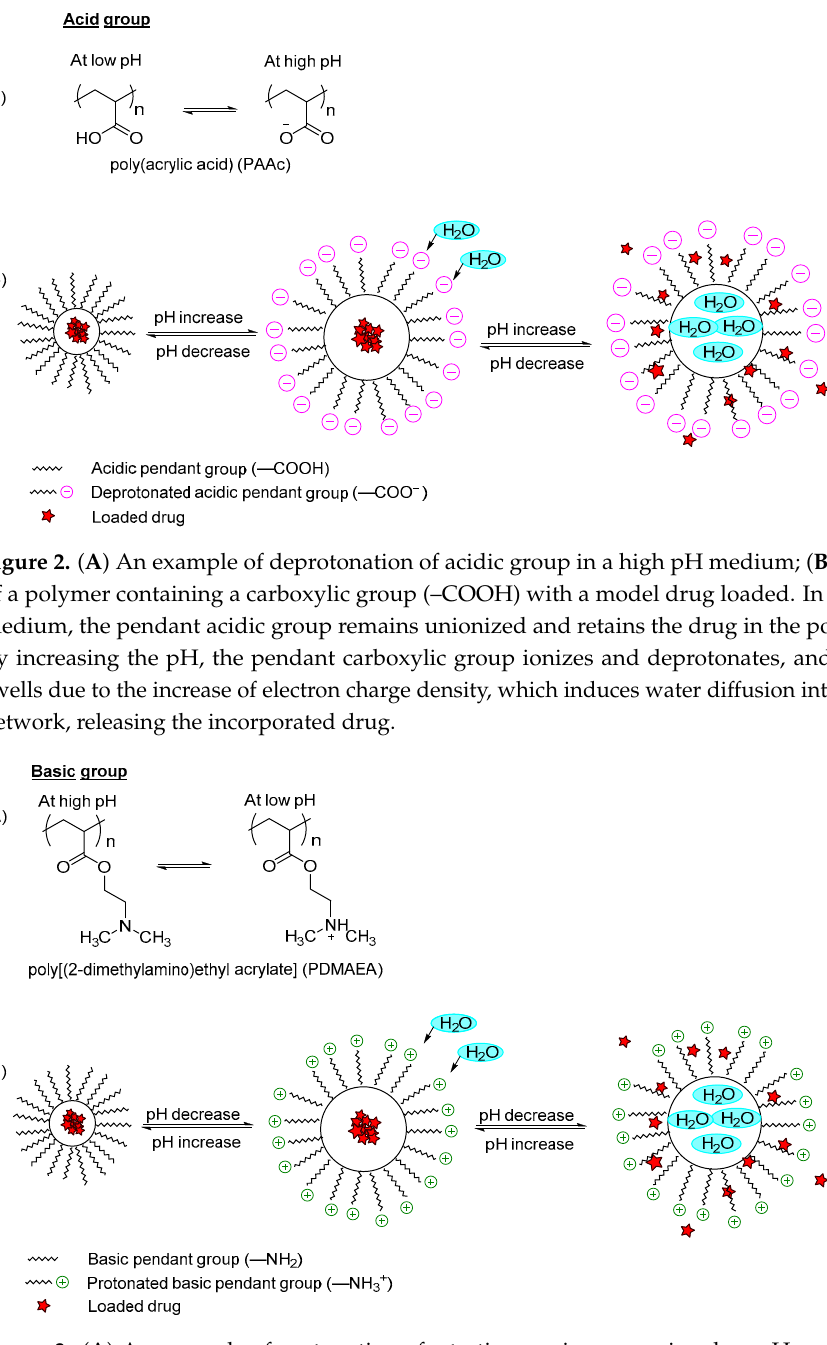
Figure 3. ( A ) An example of protonation of a tertiary amine group in a low pH medium; ( B ) An example of a polymer containing an amino group (–NH 2 ) with a model drug loaded. In a basic pH medium, the pendant amino groups remain ionized and retain the drug within the polymer carrier. However, when the pH is decreased to become acidic, the amino groups were protonated and the polymer networks swelled due to the electrostatic repulsion between the neighboring positive groups, which induced water diffusion into the polymer network, releasing the incorporated drugs. both acidic pendant groups (anionic) and basic pendant groups (cationic), which are